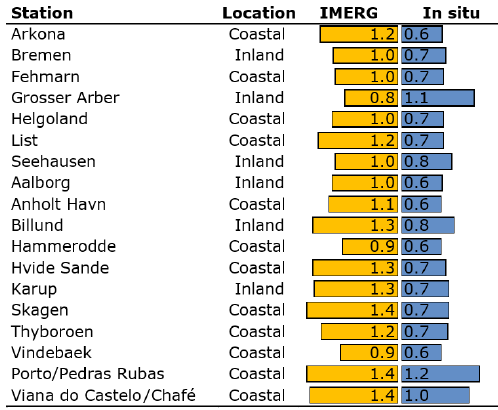
Figure 3. Comparisons between the IMERG and in situ observa- tions of the average rainfall (mm) during 30min periods in 2014–